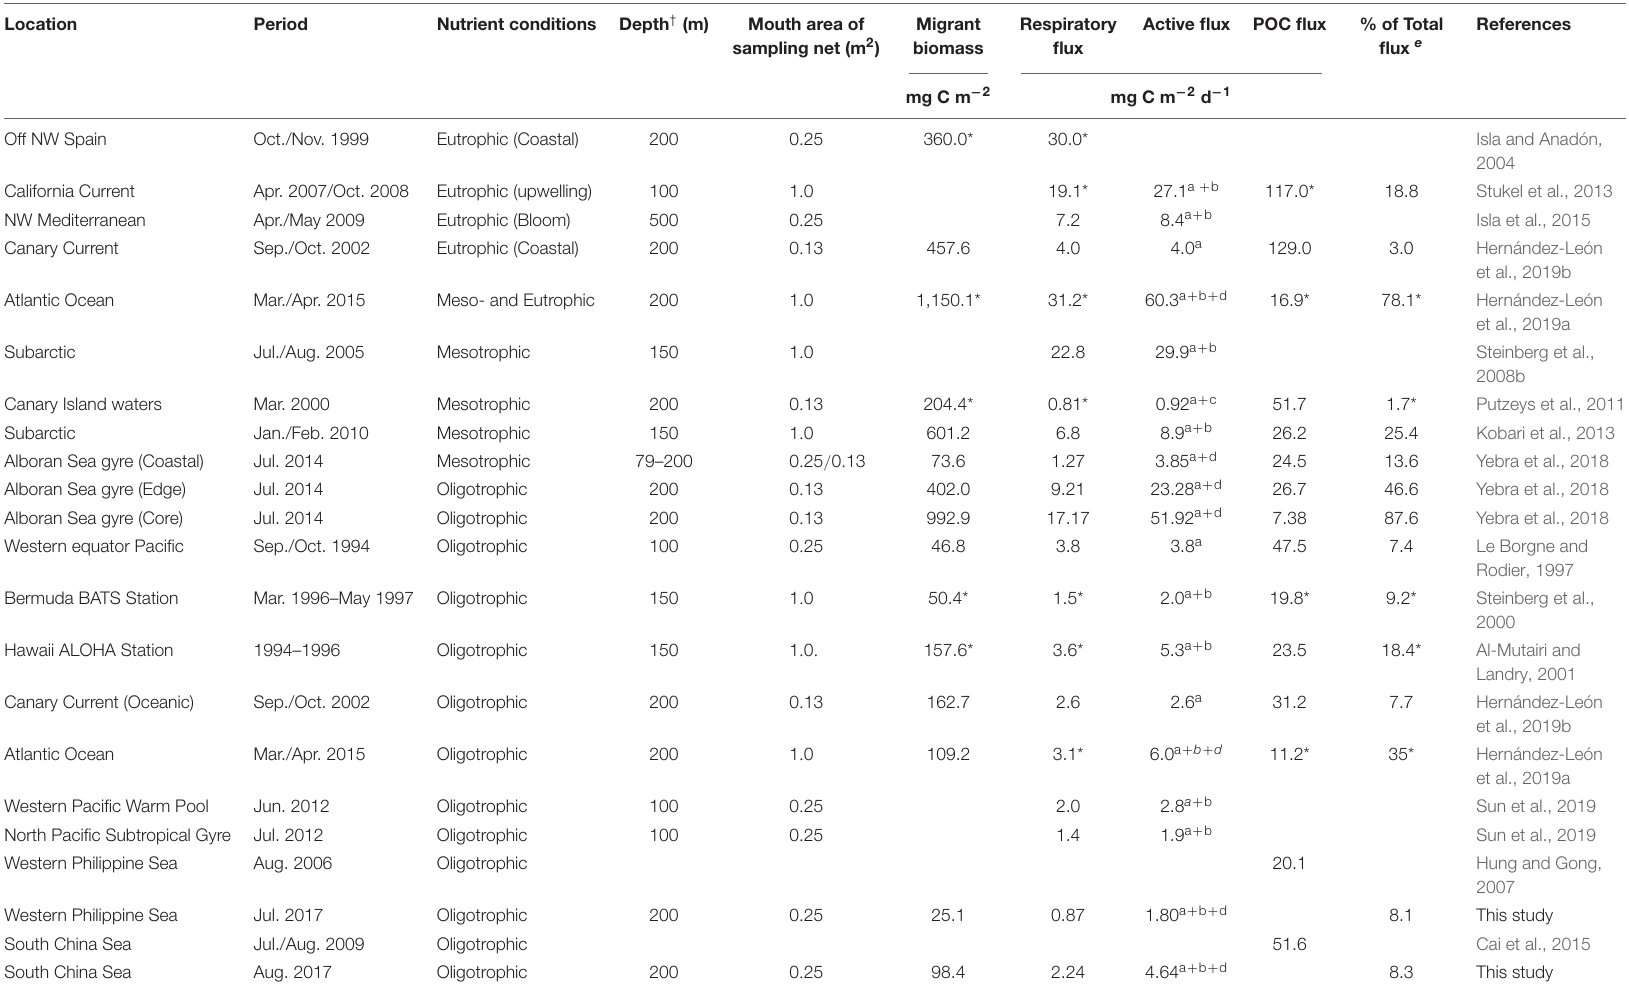
TABLE 3 | Zooplankton active flux estimated in different oceanic